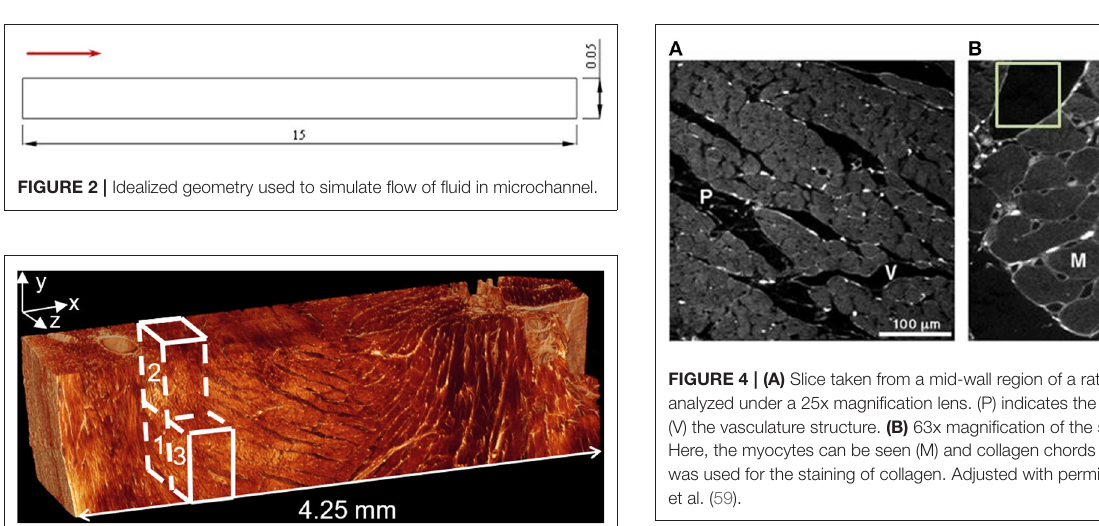
lens. The region labeled (P) indicates a cleavage plane, which